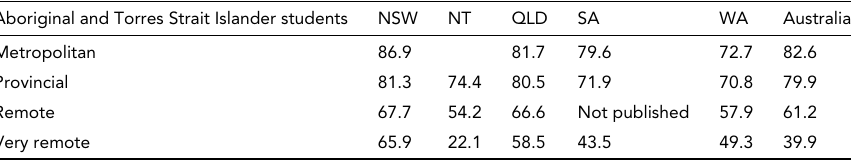
Source: Australian Curriculum Assessment and Reporting Authority